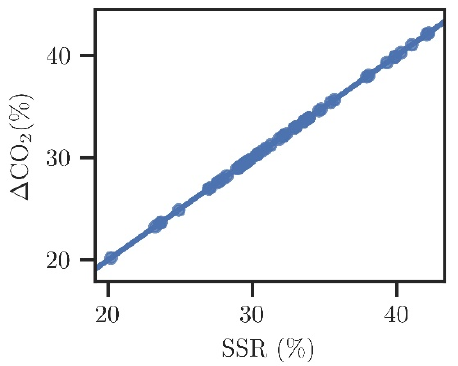
Figure 11. Correlation between annual self-su ffi ciency and reduction of CO 2 emissions (3 kWp PV).